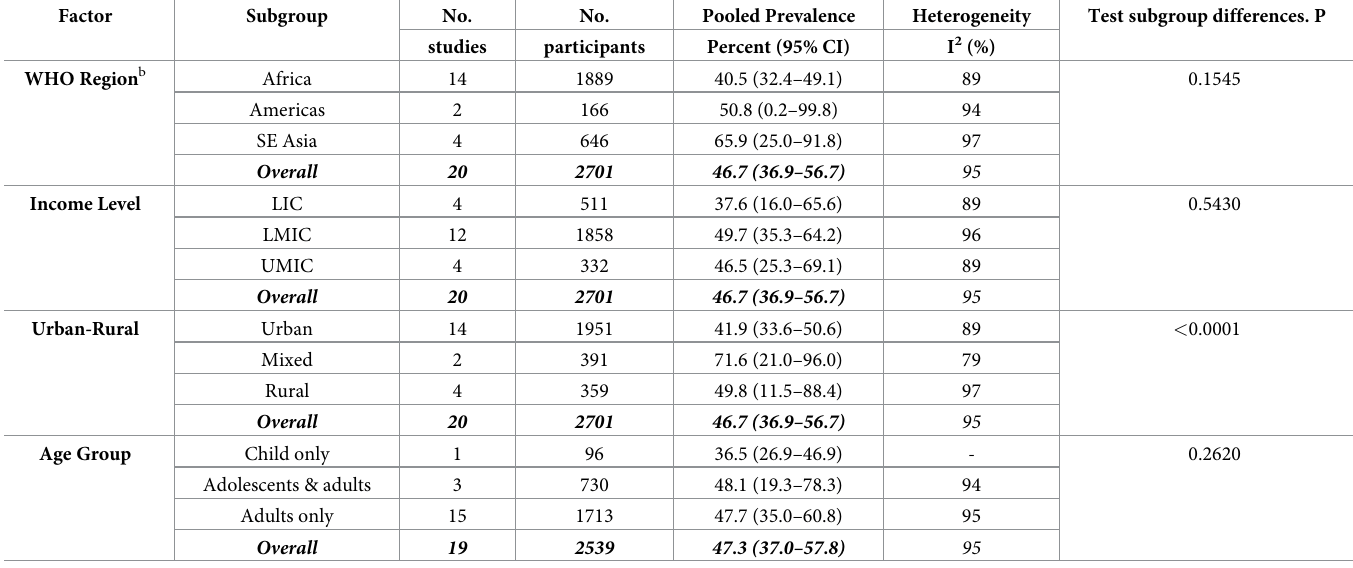
Table 4. Factors associated with residual abnormal lung function following TB.